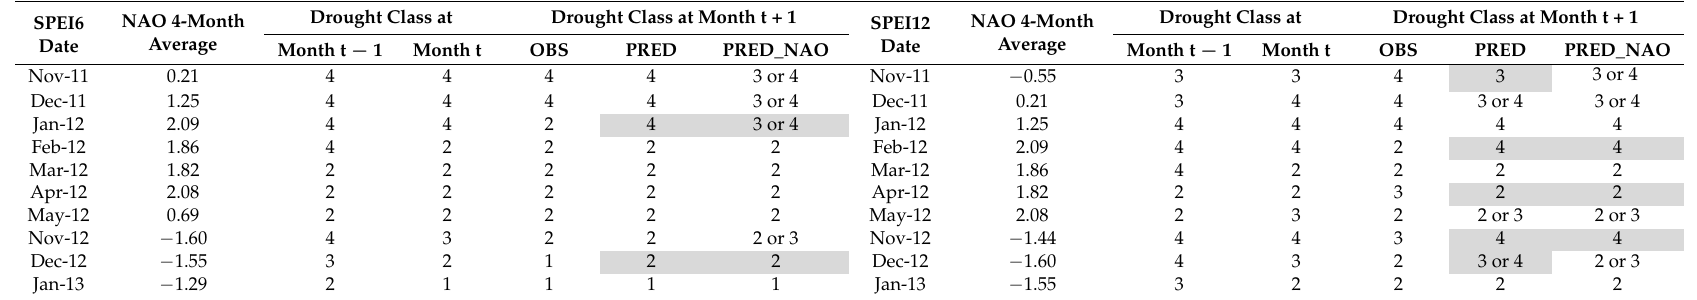
− 0.73 − 0.69 Table 7. The SPEI6 and SPEI12: Comparison between observed (OBS) and predicted drought class transitions (“PRED” and “PRED_NAO”) for grid point 13 (Table